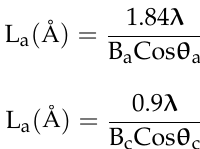
Figure 2. Methodology employed in this investigation. Figure 2 . Methodology employed in this investigation. Figure 2. Methodology employed in this Figure 2 . Methodology employed in this investigation.